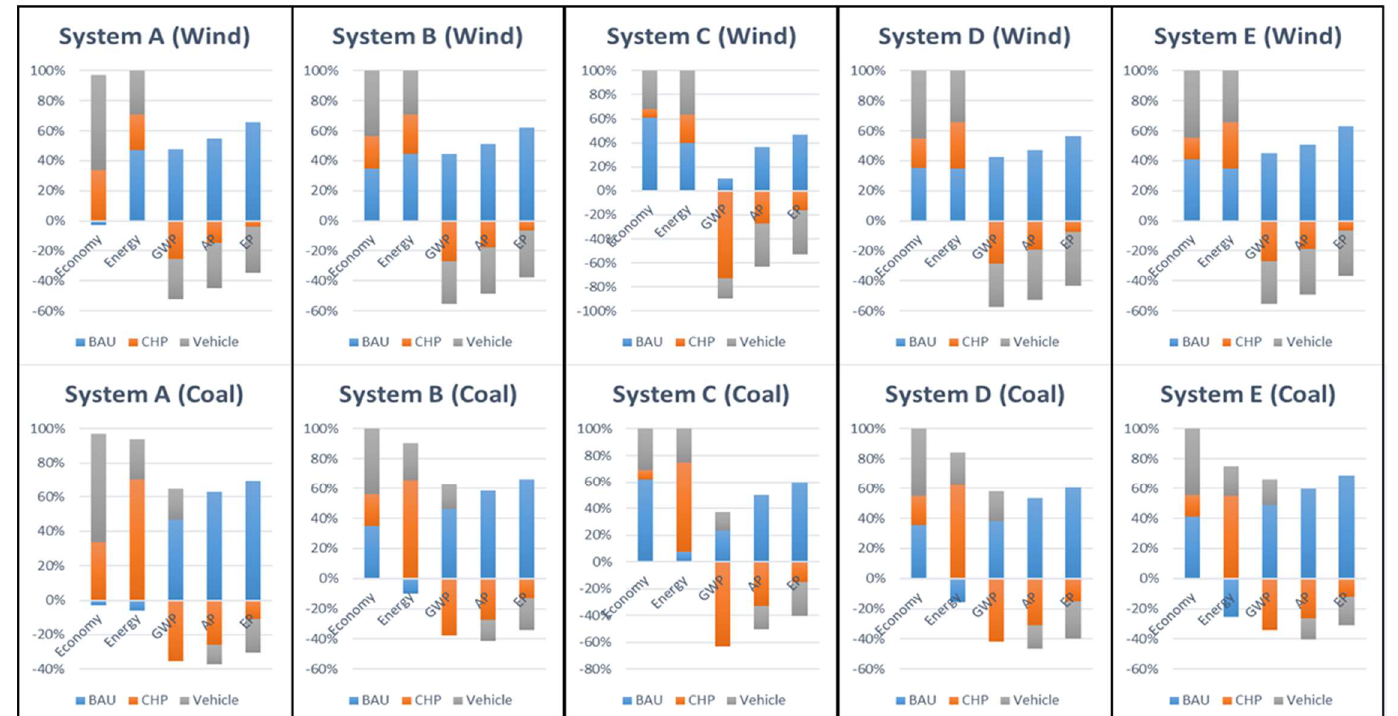
Figure 5. The results for the systems studied. Negative numbers in AP, EP, and GWP indicate that the system contributes to a total reduction of the emission; therefore, a large negative number is desirable. For Economy and Energy, the net results are presented, so a large positive number is desirable for those perspectives.